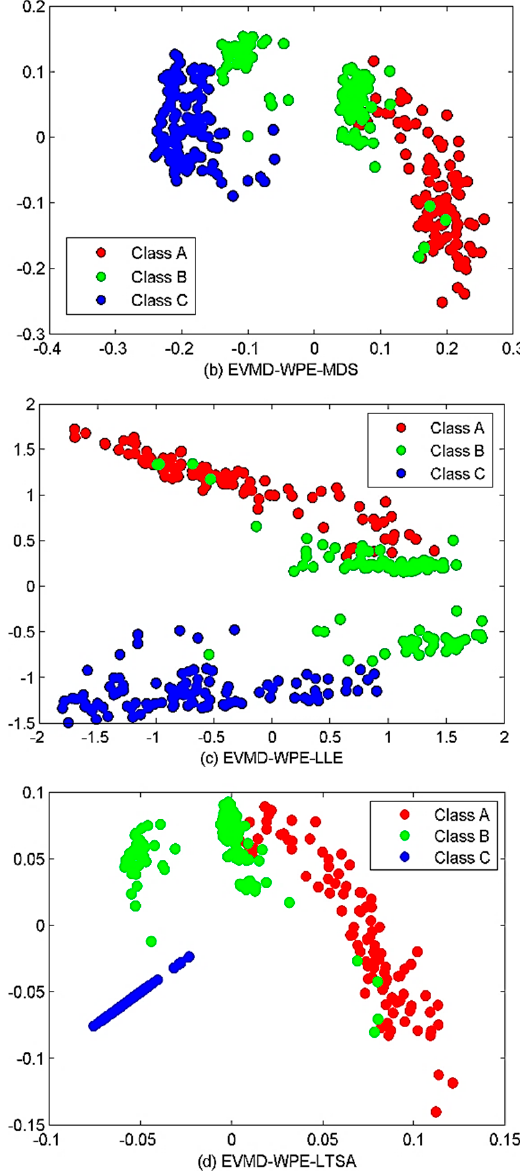
Figure 16. The clustering results of the four algorithms. ( a ) EVMD-WPE-PCA; ( b ) EVMD-WPE- MDS; ( c ) EVMD-WPE-LLE; ( d ) EVMD-WPE-LTSA. Table 3. The classification accuracy and computational complexity under different algorithms.